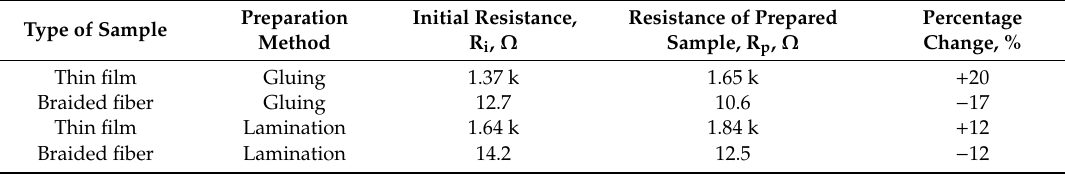
Table 1. Changes in resistance of the thin film and braided CNT fiber transparent and flexible samples before and after lamination and gluing. Percentage change has been calculated as (R i − R p / R i ) ×